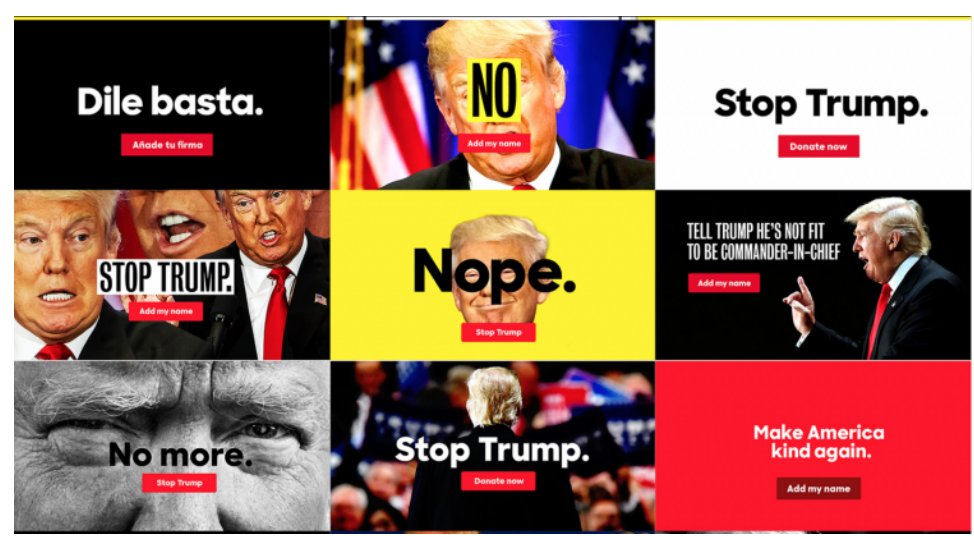
Figure 5: Anti-Trump Hillary Clinton digital advertisements Source: Hillary for America Design 2016